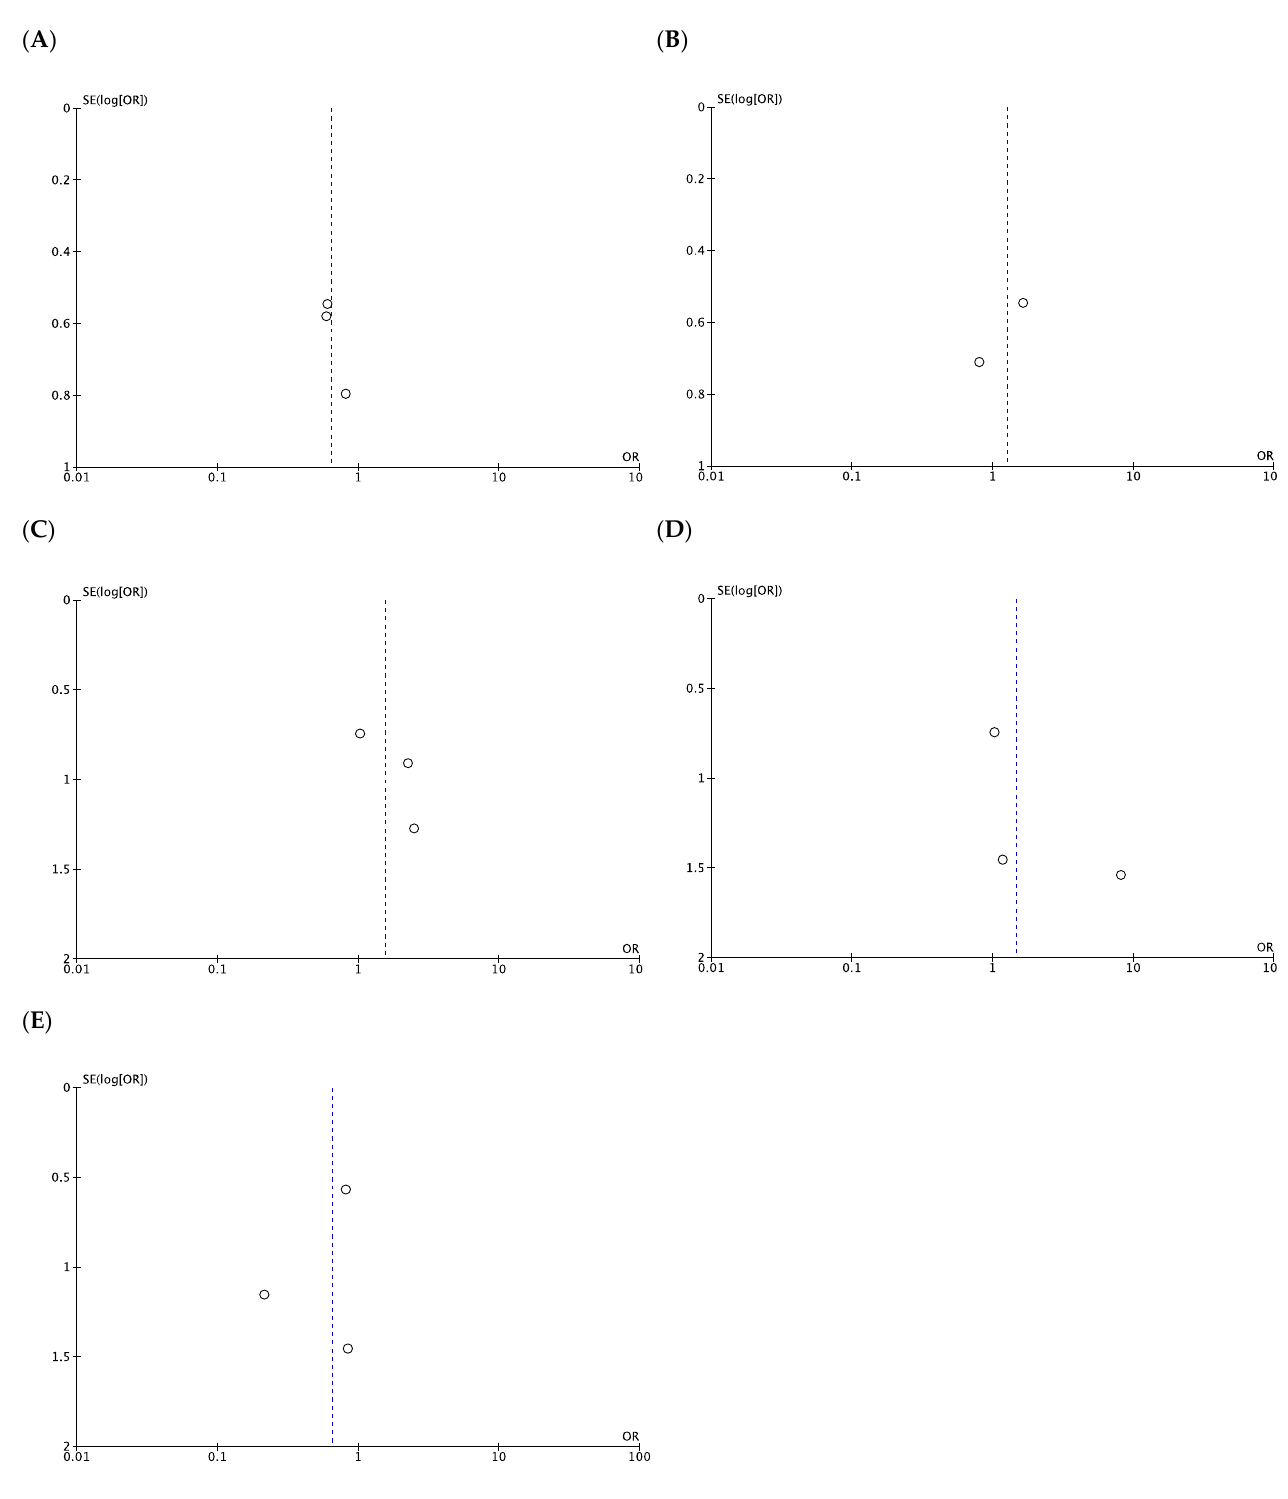
Figure 4. Funnel plots of the meta-analysis results of drug-coated balloons (DCB) vs. plain balloons (PB) angioplasty in studies. ( A ). Target lesion vascularization. ( B ). One-year primary patency. ( C ). One-year assisted primary patency. ( D ). One-year secondary patency. ( E ). Graft occlusion.